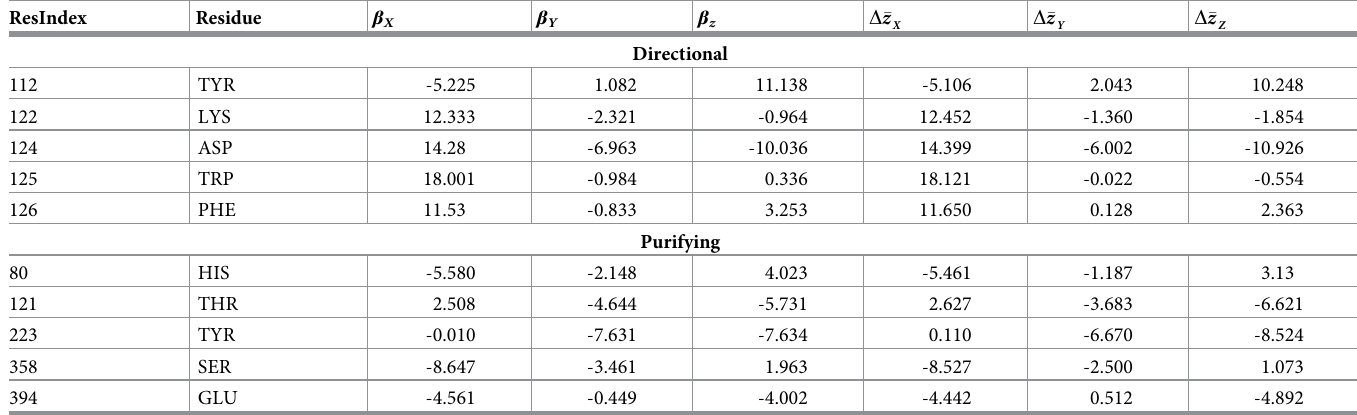
Table 2. Selection gradient in the top 5 residues. Top panel shows the residues where at least one of its coordinates is under directional selection and the sum of their absolute values is the highest. Bottom panel contains the information of residues where at least one of its coordinates is under purifying selection, and the sum of the raw values are the lowest.